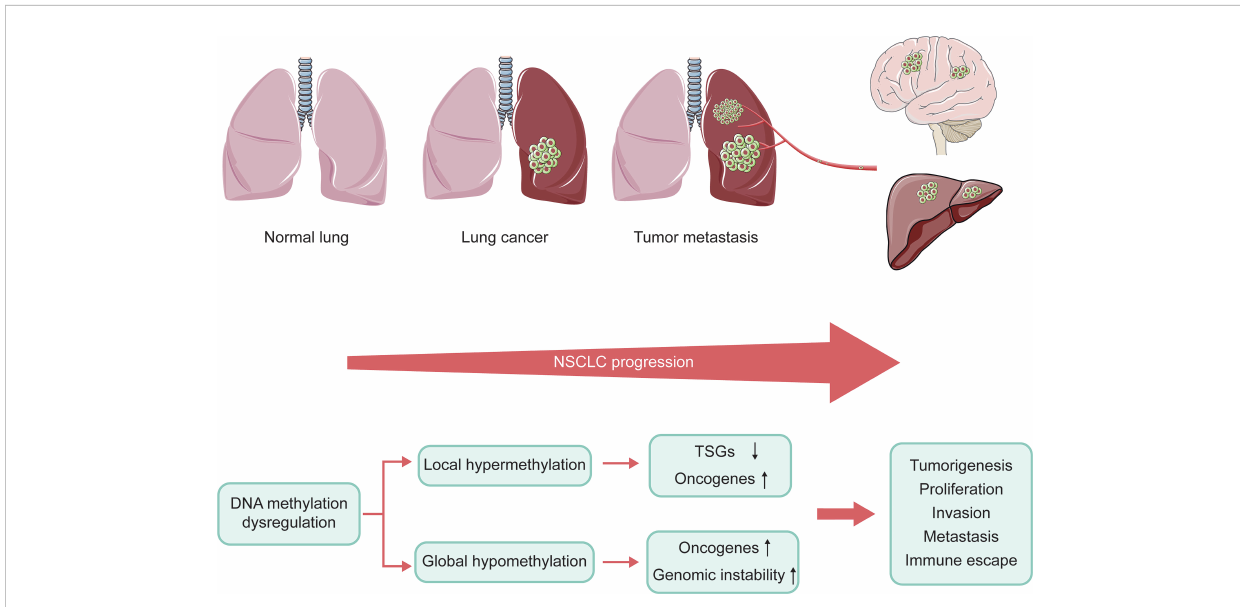
FIGURE 2 Connection of DNA methylation and the progression of NSCLC. NSCLC progression is caused by inactivation of TSGs, oncogenes activation, and genomic instability due to dysregulation of DNA methylation. NSCLC, non-small cell lung cancer; TSGs, tumor suppressor